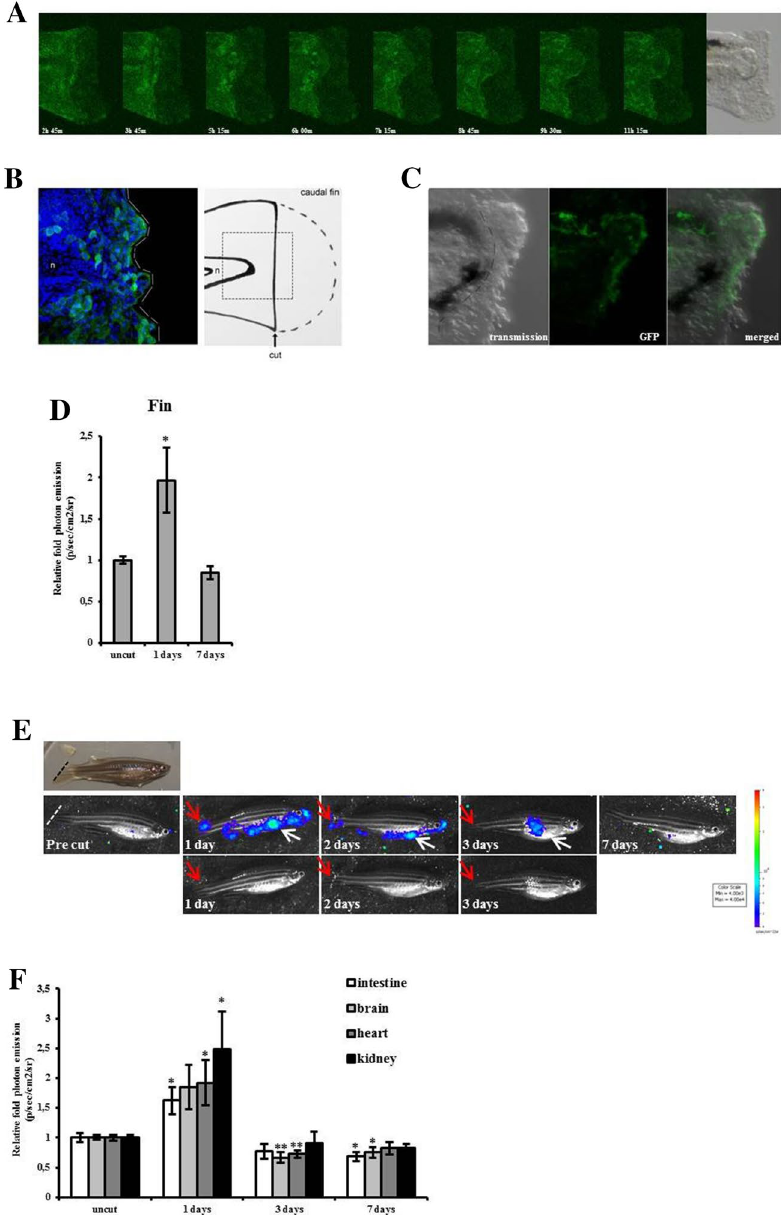
Figure 5. Caudal fin regeneration in MITO-Luc/GFP zebrafish. ( A ) Summary frame pictures of GFP during caudal fin regeneration in a 3 dpf embryo. The tridimensional images are the results of a merge of nine different layers acquisition (Z-stack). The dynamic of blastoma growth is clearly visible. Bright light image of the fin is shown in the last picture. ( B ) Immunofluorescence analysis of GFP-DAPI merge 1 day after fin clip in a 3 dpf embryo. The recruitment of GFP positive cells on the marginal edge is visible. Schematic representation of fin clip is shown. Notocord (n) is shown as anatomical reference. ( C ) Confocal imaging of GFP positive cells during regeneration of the caudal fin in a MITO-Luc/GFP 2 2 dpf live embryo. Dotted line in the left image indicates the amputation site, made 24 h before the acquisition. ( D ) Relative quantification of fin from adult zebrafish after fin clip. Luciferase activity was measured at 1 and 7 days after fin clip. Uncut fins were used as control. The error bars are mean standard deviations from six samples for each group. Asterisks denote significant differences between control and treated groups assessed by t-test (*p < 0.05). ( E ) BLI of representative MITO-Luc/GFP 1 zebrafish longitudinal analysis (pre-cut, 1 day, 2 days, 3 days and 7 days) after fin clip procedure. Red arrows indicate light coming from regenerating caudal fin. White arrows indicate light coming from the abdominal organs. A bright picture and images without luminescence signal are shown for 1, 2 and 3 days as anatomical references. Light emitted from the animals appears in pseudocolor scaling. ( F ) Ex vivo BLI of zebrafish organs after fin clip. Relative fold induction of photon emission is presented. Luciferase activity was measured in dissected organs from zebrafish sacrificed 1, 3, and 7 days after fin clip. Uncut zebrafish were used as control group. The error bars are mean standard deviations from six fishes for each group. Asterisks denote significant differences between control and treated groups assessed by t-test (*p < 0.05, **p <